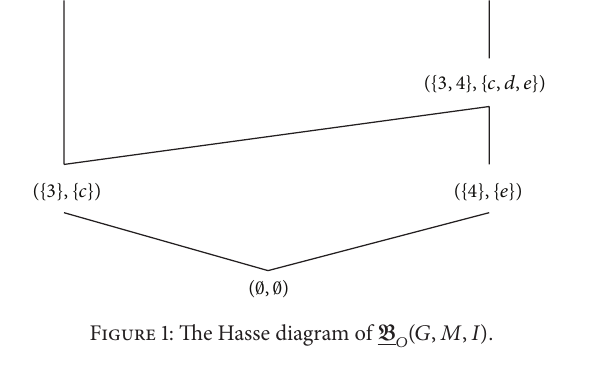
Figure 1: The Hasse diagram of B 𝑂 (𝐺, 𝑀,𝐼) .